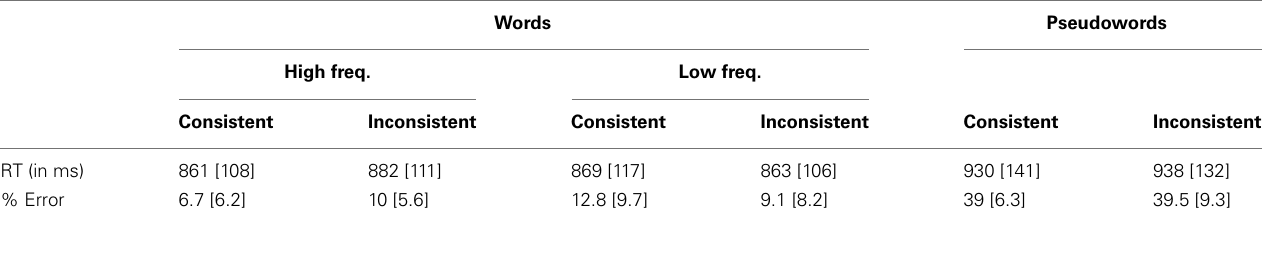
Table 2 | Mean raw RTs for correct responses and error rates (SD in brackets) observed in the noise